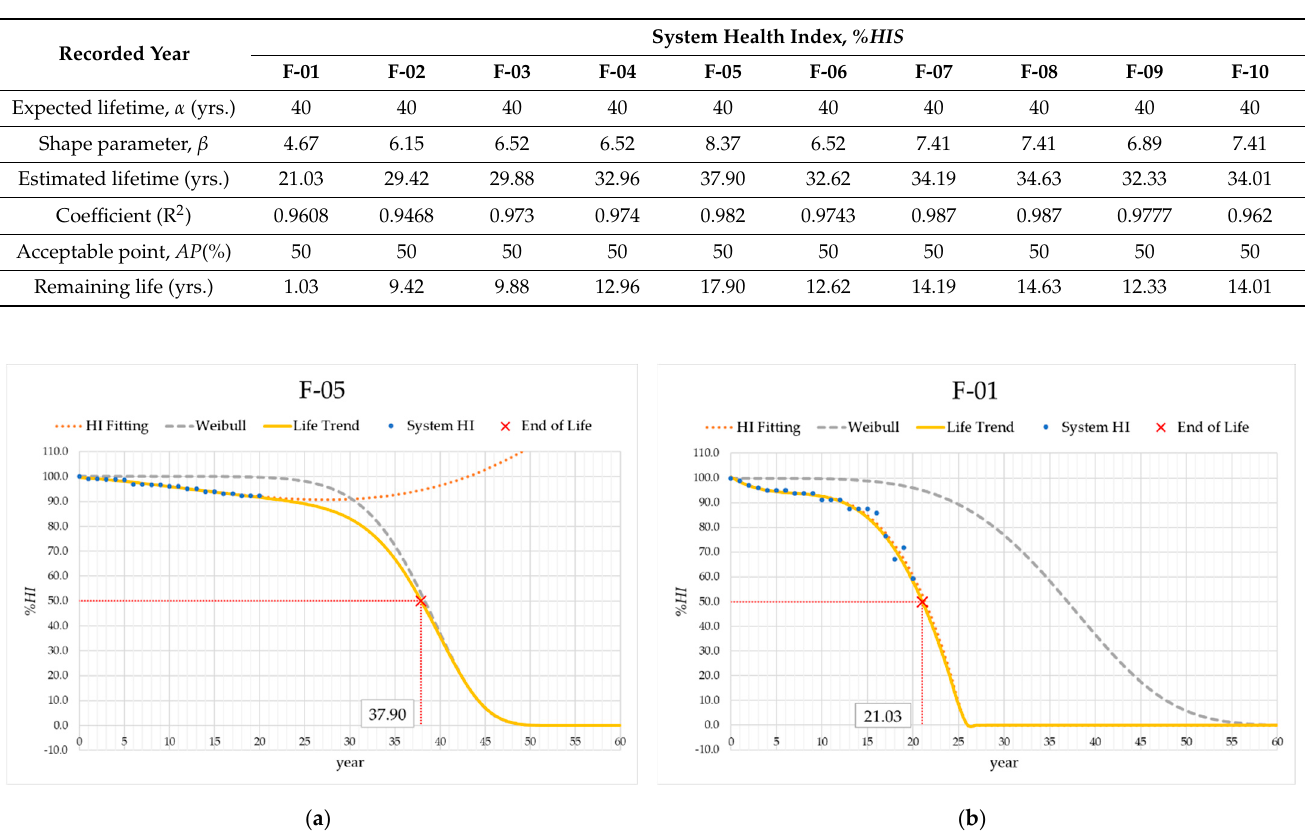
Figure 8. Lifetime curve and determination of the expected lifetime of the best and the worst cable system. ( a ) The best estimated lifetime curve of F-05 and ( b ) the worst estimated lifetime curve of F-01.